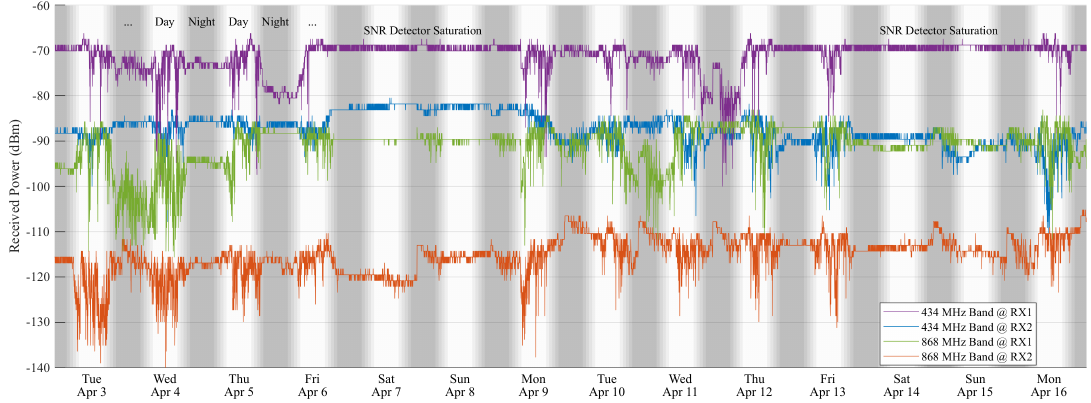
Figure 13. 14 days of indoor received power